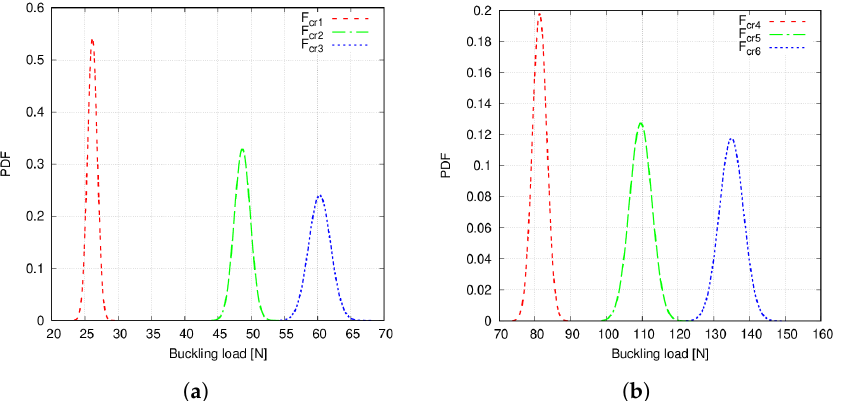
Figure 15. ( a ) Case 2 F cr 1 , F cr 2 and F cr 3 PDFs, ( b ) Case 2 F cr 4 , F cr 5 and F cr 6 PDFs. Fibre volume fraction is treated as a Gaussian random variable with mean value V f = 0.60 and standard deviation = 0.05 and no fibre σ V f